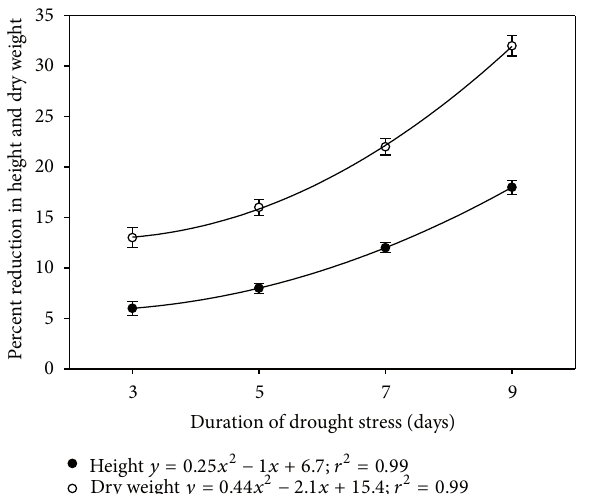
Figure 2: Percent reduction in plant height and dry weight as affected by the duration of drought stress in days. Data pooled over accessions. Points are means ± S.E.